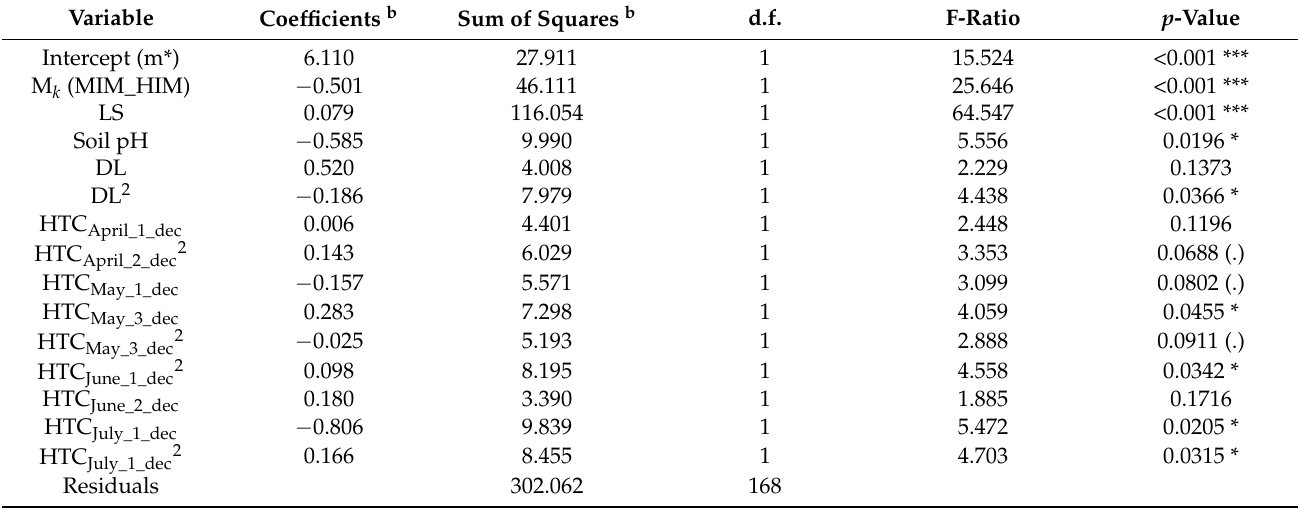
Table 2. ANCOVA analysis of covariance for the model after variable selection based on the Akaike information